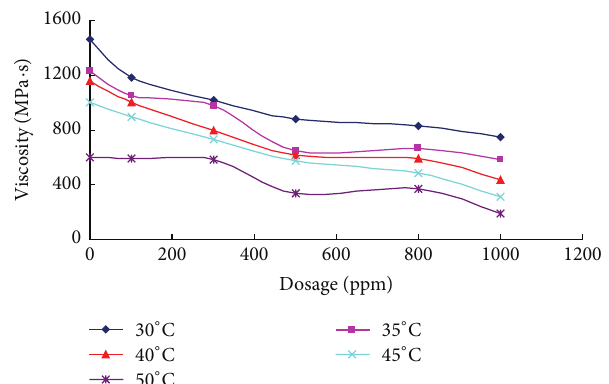
Figure 6: The relation of dosage and